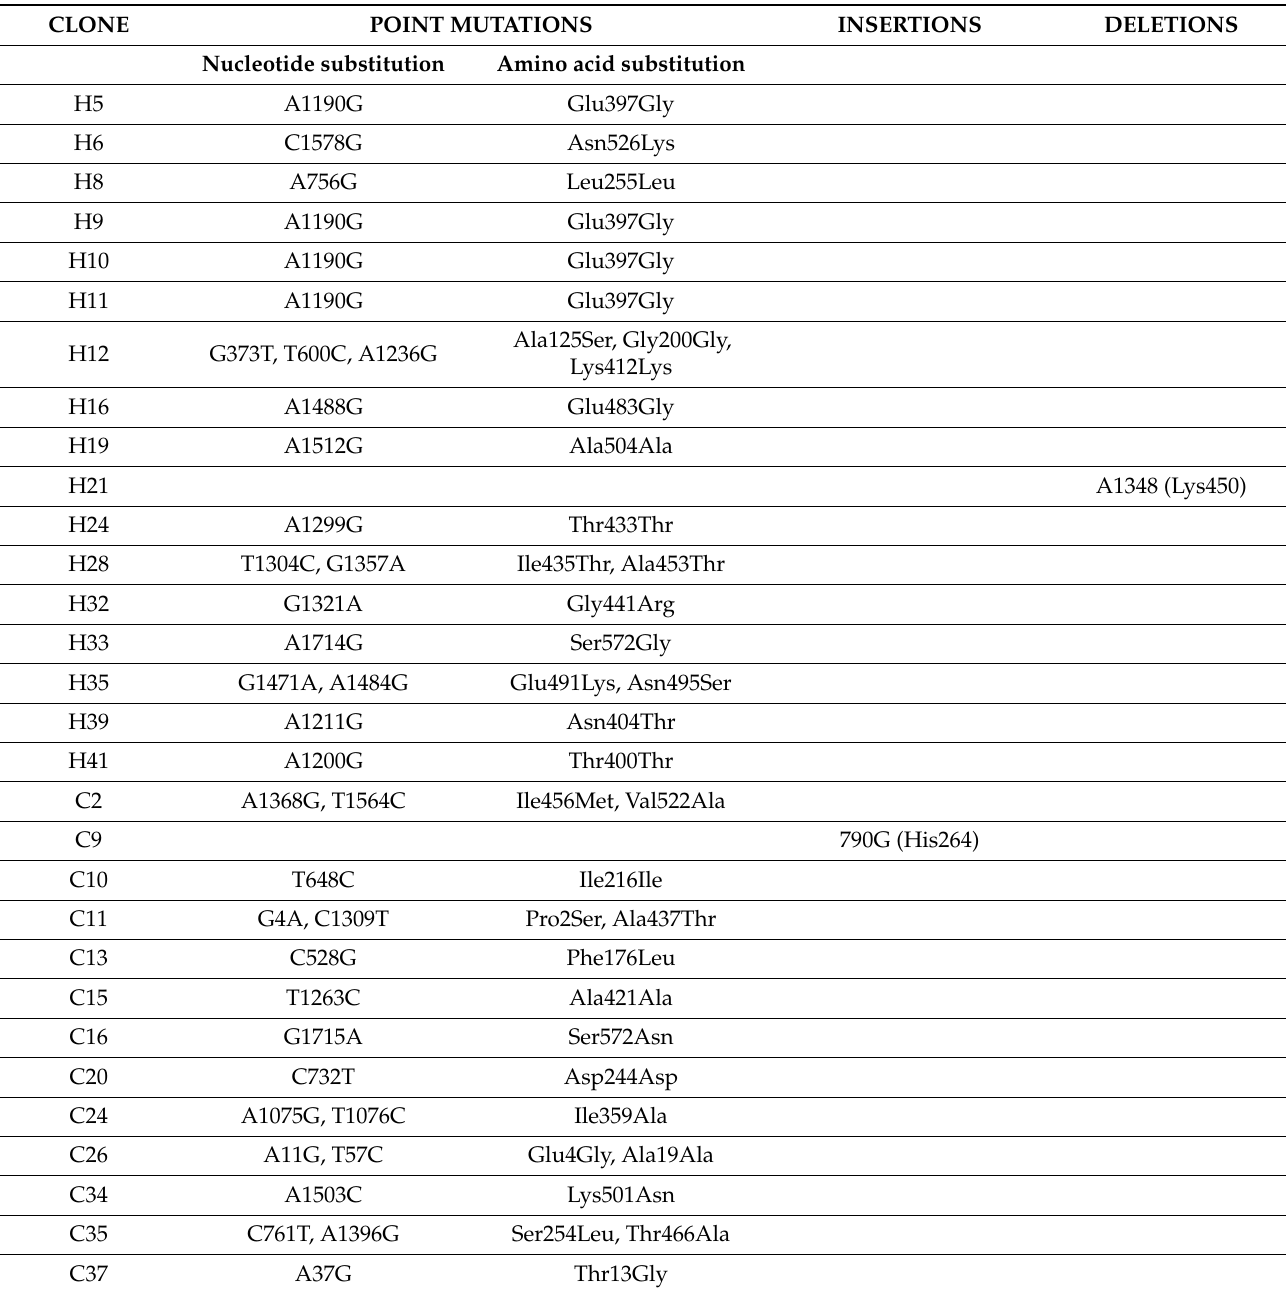
Table 3. Nucleotide position due to mutations in dnaK transcripts from HCT116 infected with MF-I1 (H1 to H41), MF-I1 grown in axenic conditions in 243 medium (C1 to C40) and free bacterial grown in McCoy’s 5A medium (M1 to M40). Amino acid changes are indicated in the single point